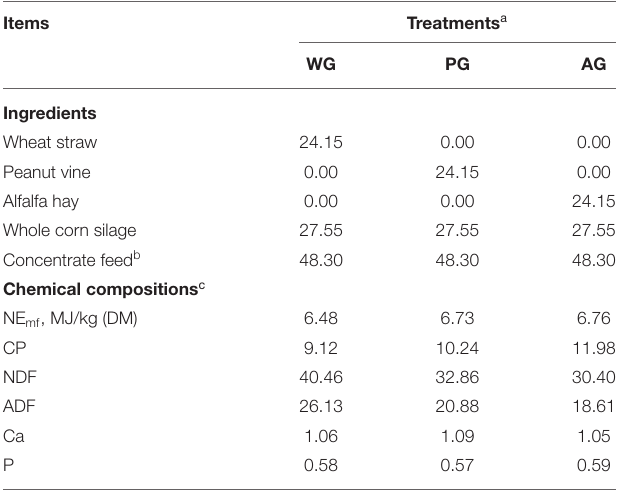
TABLE 2 | Ingredients and chemical compositions of trial diets (DM%). Items